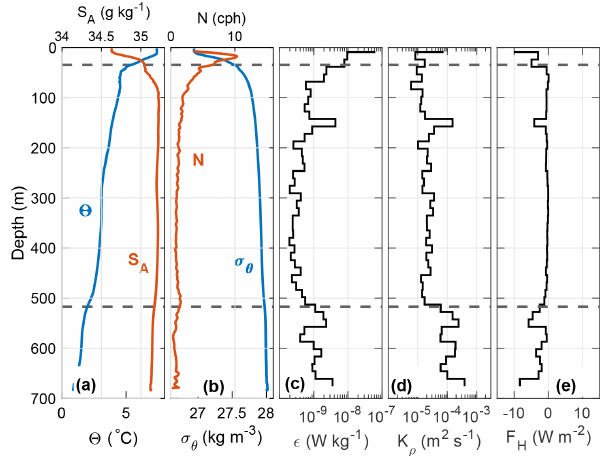
Figure 7. Temporal mean of measurements collected by the mi- crostructure profiler at station R1, Section A. (a) (cid:50) (blue) and S A (red); (b) σ θ (blue) and buoyancy frequency N (red); (c) 15m bin-averaged dissipation of TKE (cid:15) ; (d) eddy diffusivity K ρ ; and (e) vertical heat flux F H . Dashed lines show the upper and lower boundaries of the stream tube. Water depth is